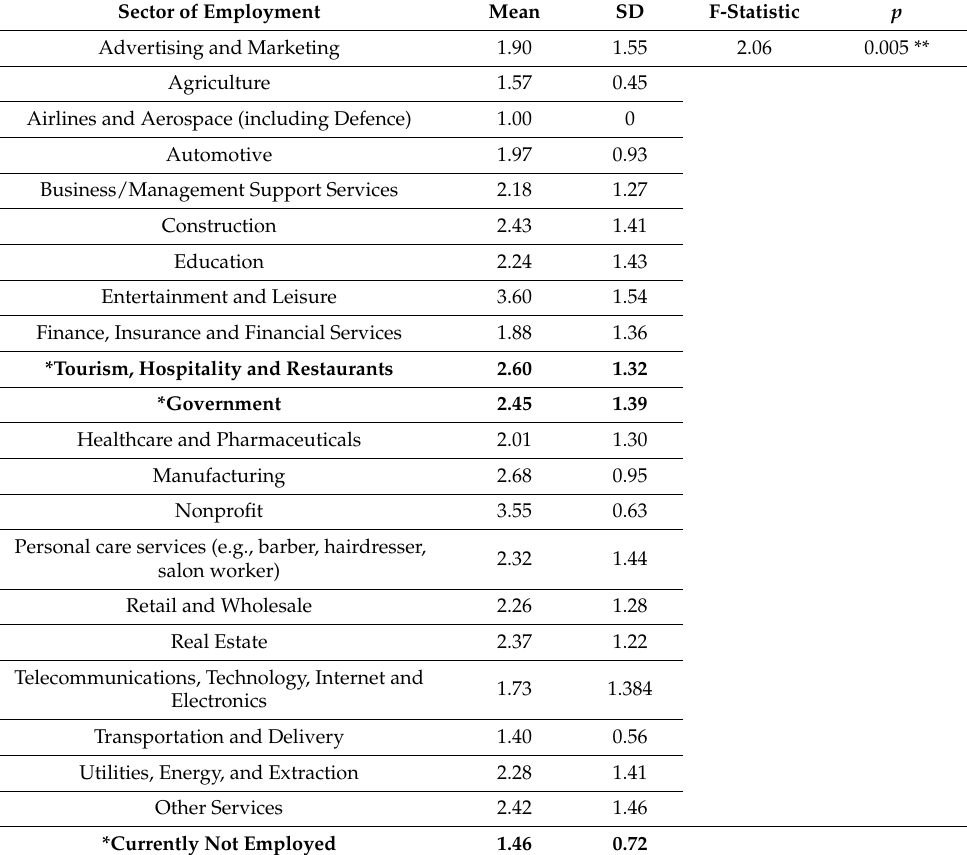
Table 5. Perceived COVID-19 vaccine pressure by sector of employment (employed respondents